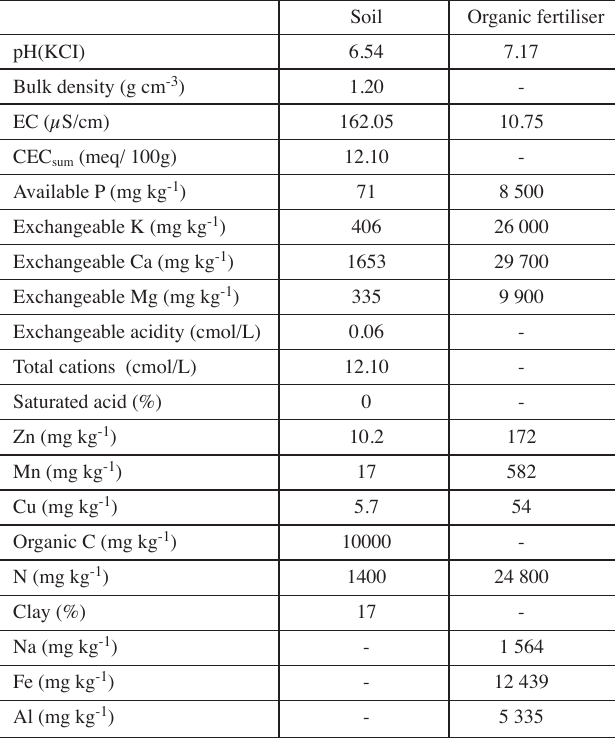
Tab. 2: Effect of organic and inorganic fertilisers on plant height (cm) of Solanum nigrum L. cultivated in the greenhouse.